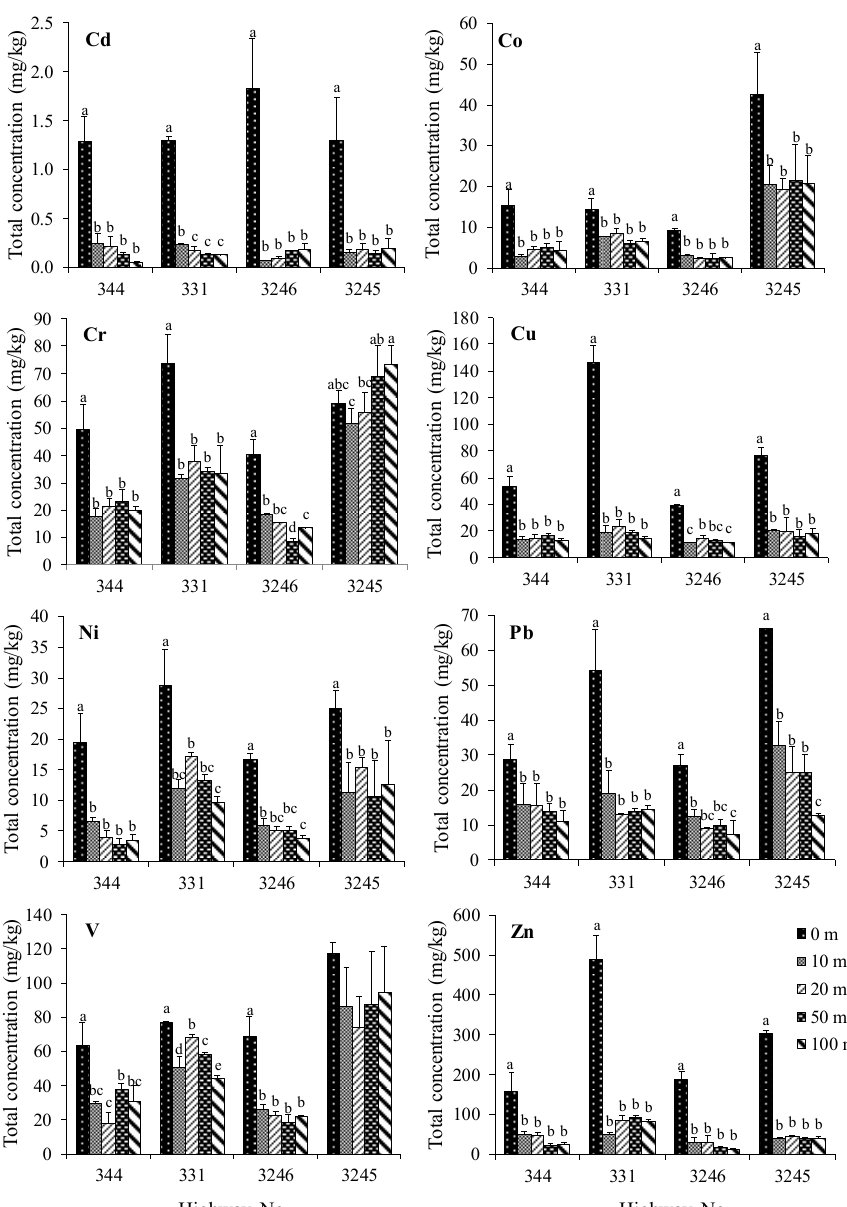
Figure 4. Mean total concentrations of Cd, Co, Cr, Cu, Ni, Pb, V, and Zn (mg kg − 1 ) in sugarcane growing soils at different distances from the road edge. The columns with different alphabets indicate significant differences and those without alphabets indicate insignificant differences in the soil concentrations ( p < 0.05), and error bars indicate ±SD.